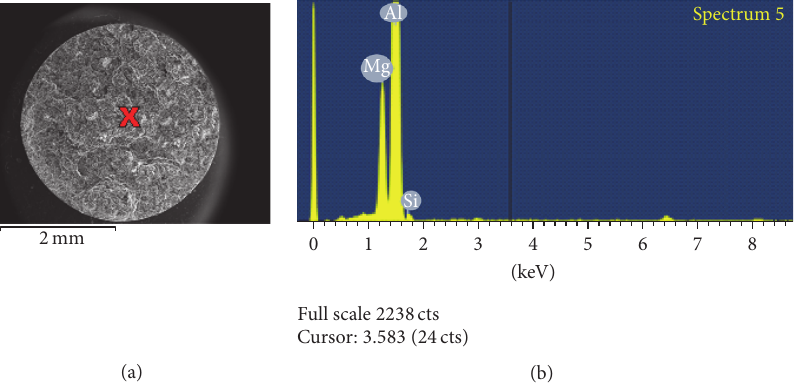
Figure 9: (a) An SEM image of the fracture surface of a specimen from Experiment 4; (b) EDX analysis at the location marked “X” in